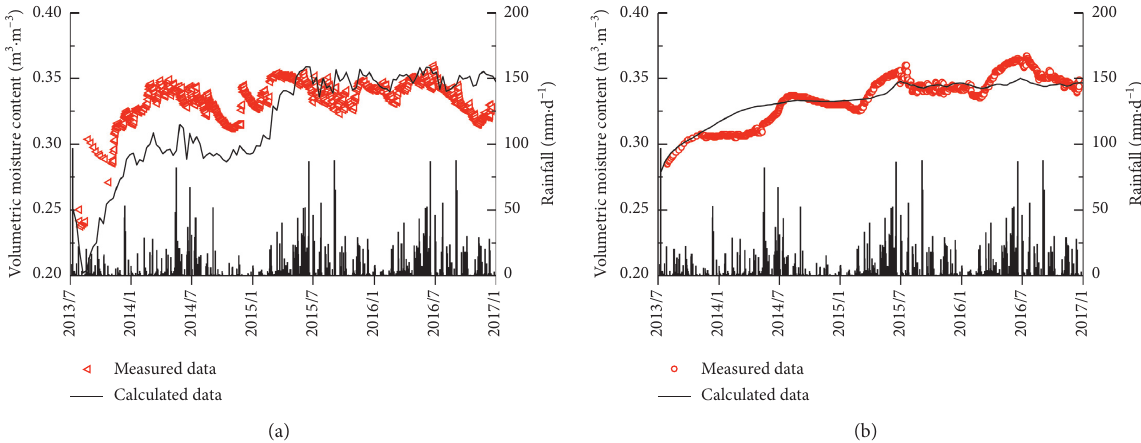
Figure 7: Comparison between measured and calculated volumetric moisture contents: (a) the location of sensor #6; (b) the location of sensor #4 [23].